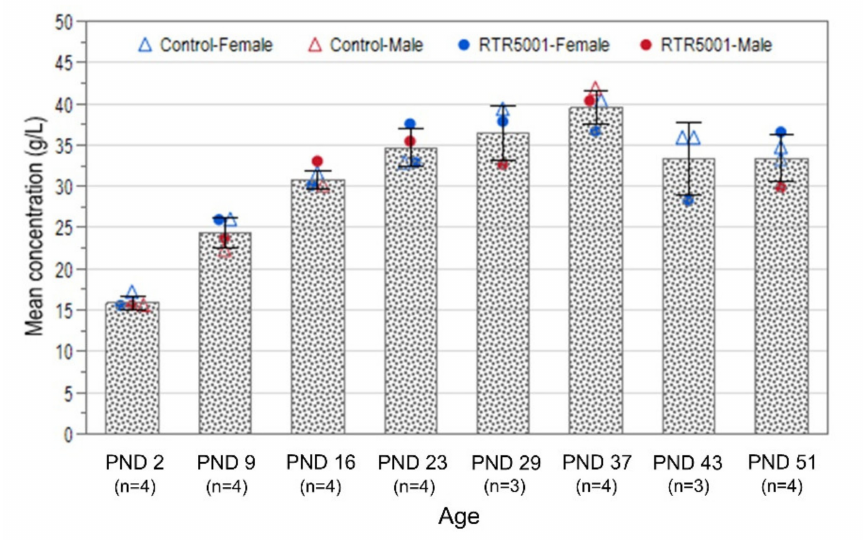
Figure 5. Mean ± SD plasma albumin concentration in control and RTR5001-treated juvenile minipigs in the different juvenile age